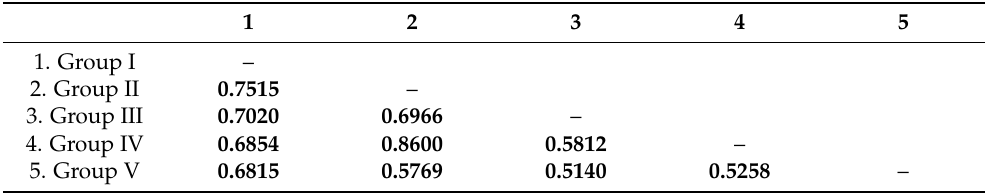
Table 2. Pairwise F ST comparison between five phylogroups of G. crinale .